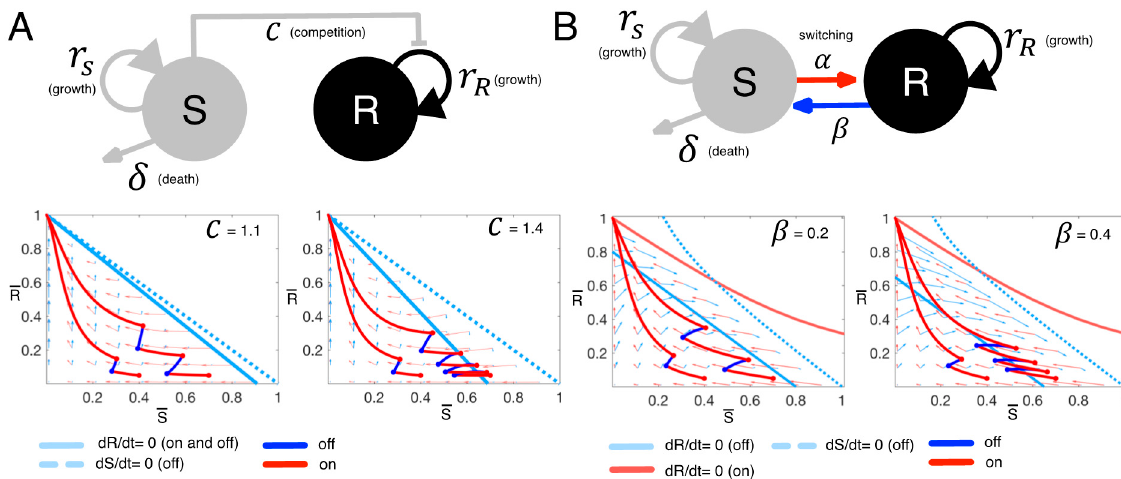
Figure 2. Tumor dynamics for the two mathematical models of tumor growth and treatment. ( A ) Upper panel: LV model structure. 𝑆 : drug-sensitive cancer cell population, outgoing arrow: death by a therapy, 𝑅 : drug-resistant cancer cell pop- ulation, the line to 𝑅 from 𝑆 : inhibition of 𝑅 growth via competition, circular arrow: growth. Bottom panel: temporal dynamics under intermittent therapy simulation with two different competition coefficients ( 𝐶 = 1.1 on the left and 𝐶 = 1.4 on the right) and two different initial conditions ( 𝑆̅ = 0.4 and 𝑆̅ = 0.7 with 𝑅(cid:3364) = 0.05 in both scenarios, 𝑆̅ = 𝑆 𝐾(cid:3415) , 𝑅(cid:3364) = 𝑅 𝐾(cid:3415) ). Coordinates: non-dimensionalized sensitive cell 𝑆̅ (horizontal axis) and resistant 𝑅(cid:3364) (vertical axis). (1,0) represents 𝑆 = 𝐾 & 𝑅 = 0 , (0,1) represents 𝑆 = 0, & 𝑅 = 𝐾 . Rate of change of 𝑅(cid:3364) with respect to time is zero along the pale blue solid line when treatment is on and off. The rate of change of 𝑆̅ is zero along the pale blue dotted line when treatment is off. When treatment is on, the rate of change of 𝑆̅ is zero along with y-axis. Temporal dynamics of the two cell types are traced along trajectories for intermittent treatment (red: on and blue: off). ( B ) Upper panel: SW model structure. S : drug-sensitive cancer cell population, outgoing arrow: death by therapy, R : drug-resistant cancer cell population, a line from S to R : switching from S to R during treatment on, a line from R to S : switching from R to S during treatment holidays, circular arrow: growth. Bottom panel: Temporal dynamics under intermittent therapy simulation with two different R -> S switch- ing rates ( 𝛽 ) and two different initial conditions (the same as for LV simulations). The rate of change of resistant cell population with respect to time is zero along two solid lines (pale blue: treatment off and pale red: treatment on). The rate of change of 𝑆̅ is zero along the pale blue dotted line when treatment is off.